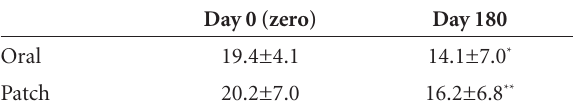
Table 1. Mini-Mental State Examination evaluation at two time points.